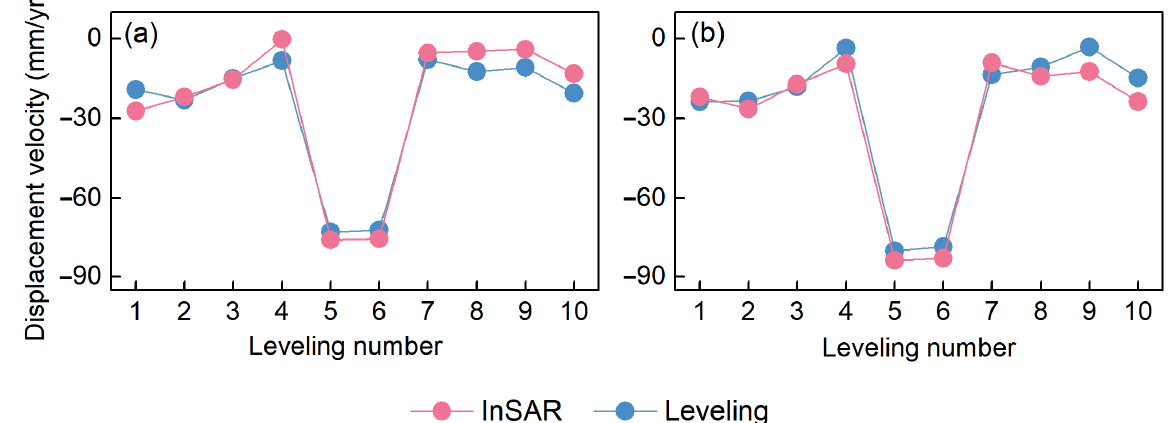
Figure 6. Comparison of the InSAR-derived surface displacement rates with those derived from GPS and leveling measurements. ( a , b ) Comparison of the ascending and descending InSAR LOS displacements, respectively, with the leveling measurements. Table 4. Statistics for validating the PS-InSAR